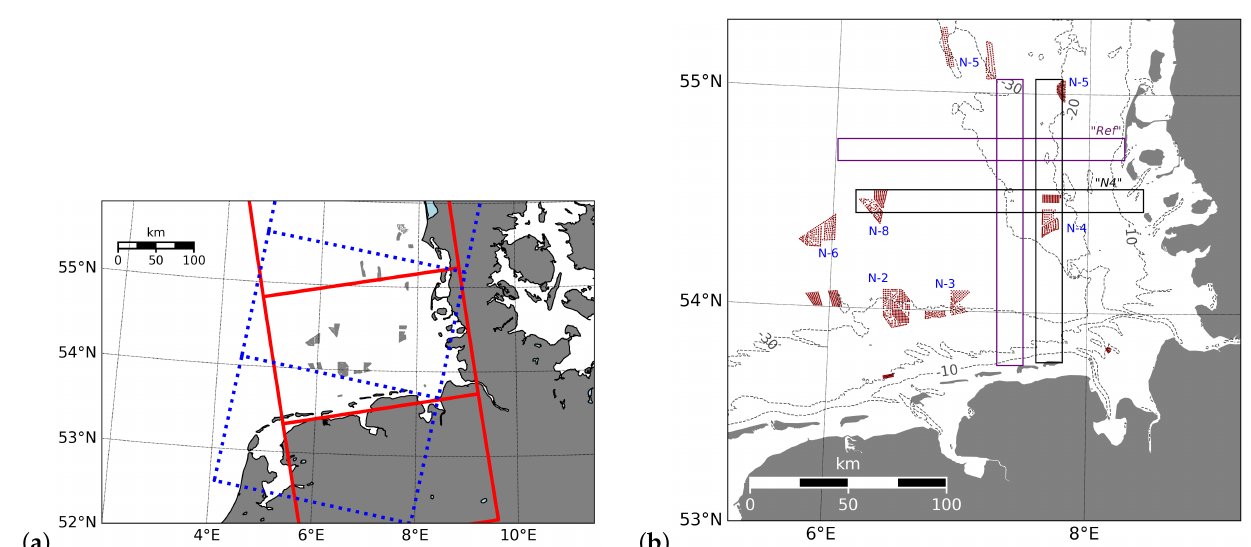
Figure 2. Sentinel-1A/B coverage of the entire German Bight ( a ). Red swath corresponds to ascending orbits (acquired around 17:16UTC) and the blue frame refers to descending orbits (acquired around 05:48UTC). ( b ) Map showing bathymetry contours with transects over which the wind speed gradi- ents are estimated. The rectangular box in purple represents the transect “Ref” in an area without influence of atmospheric wakes, while the black box indicates the transect through the cluster N-4